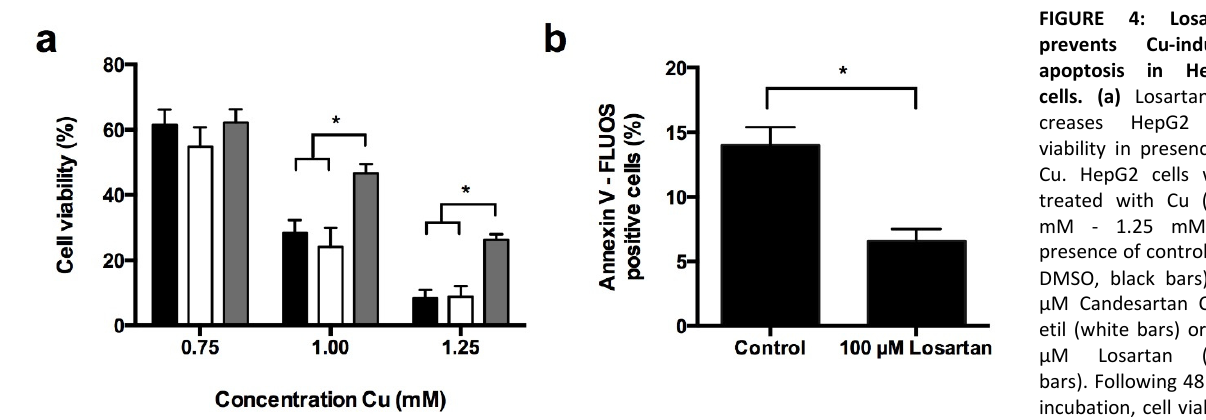
bars). Following 48 h